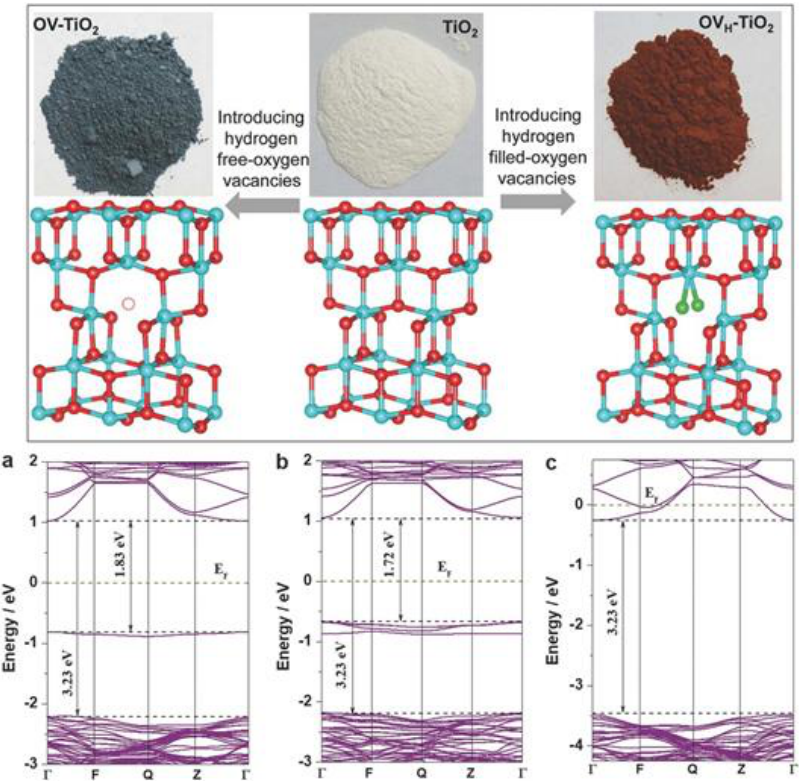
Figure 17. The color change of anatase TiO 2 powder from white to blue by introducing hydrogen-free oxygen vacancies and from white to red by introducing atomic hydrogen-mediated oxygen vacancies. The top panel shows digital images of the samples and the bottom panel shows the atomic structures of anatase TiO 2 and oxygen-deficient TiO 2 with and without atomic hydrogen. Blue and red spheres indicate titanium and oxygen atoms, respectively and green spheres represent hydrogen. The calculated band structures of TiO 2 with ( a ) OV-2H, ( b ) 4 (OV-2H) and ( c ) a neutral OV. Reproduced from [81] . Copyright (2018), Wiley-VCH Verlag GmbH & Co. KGaA, Weinheim.